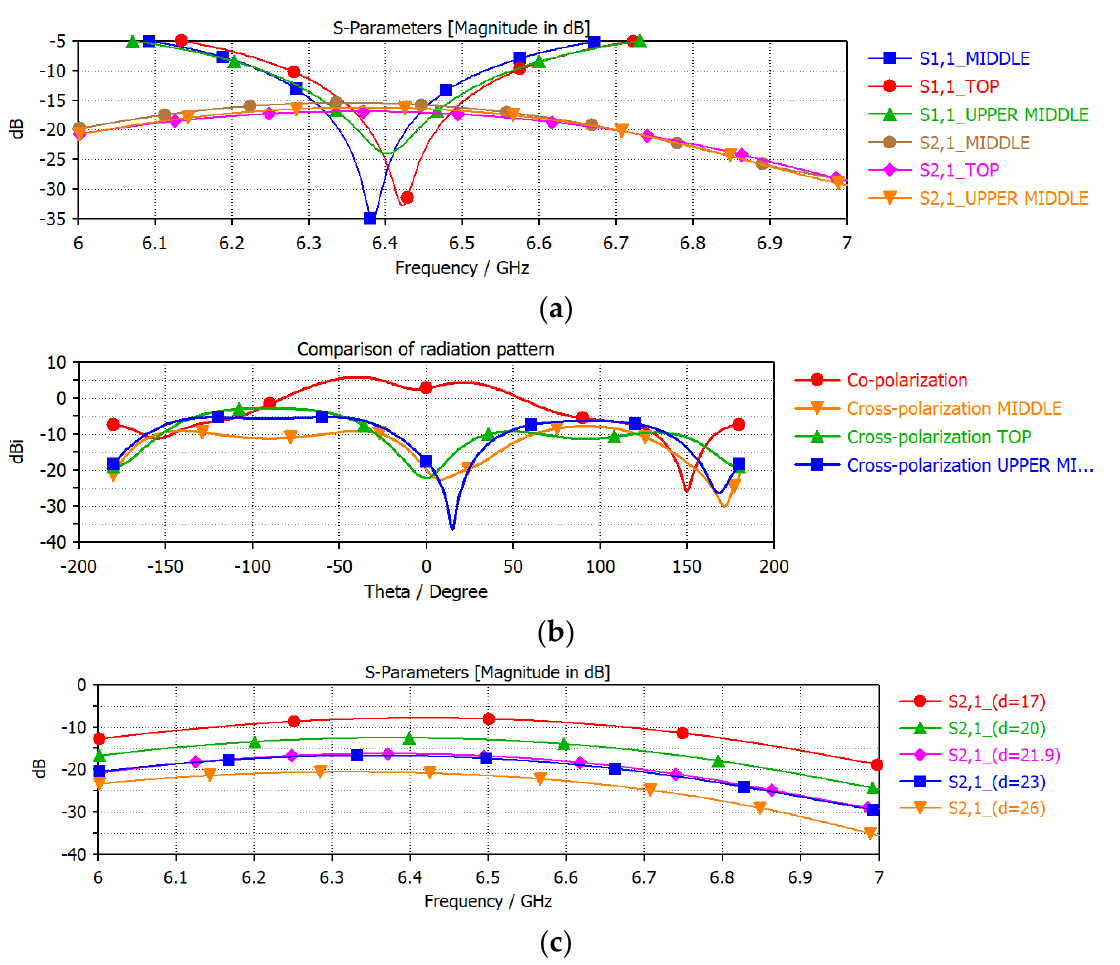
Figure 7. ( a ) Comparison of S-parameters; ( b ) Comparison of radiation pattern; and ( c ) the coupling between the antenna elements with different d .